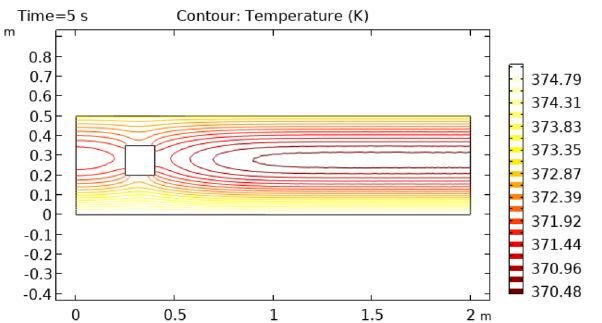
Figure 16. Contour temperature in squared cylindrical flow at t = 7 s.